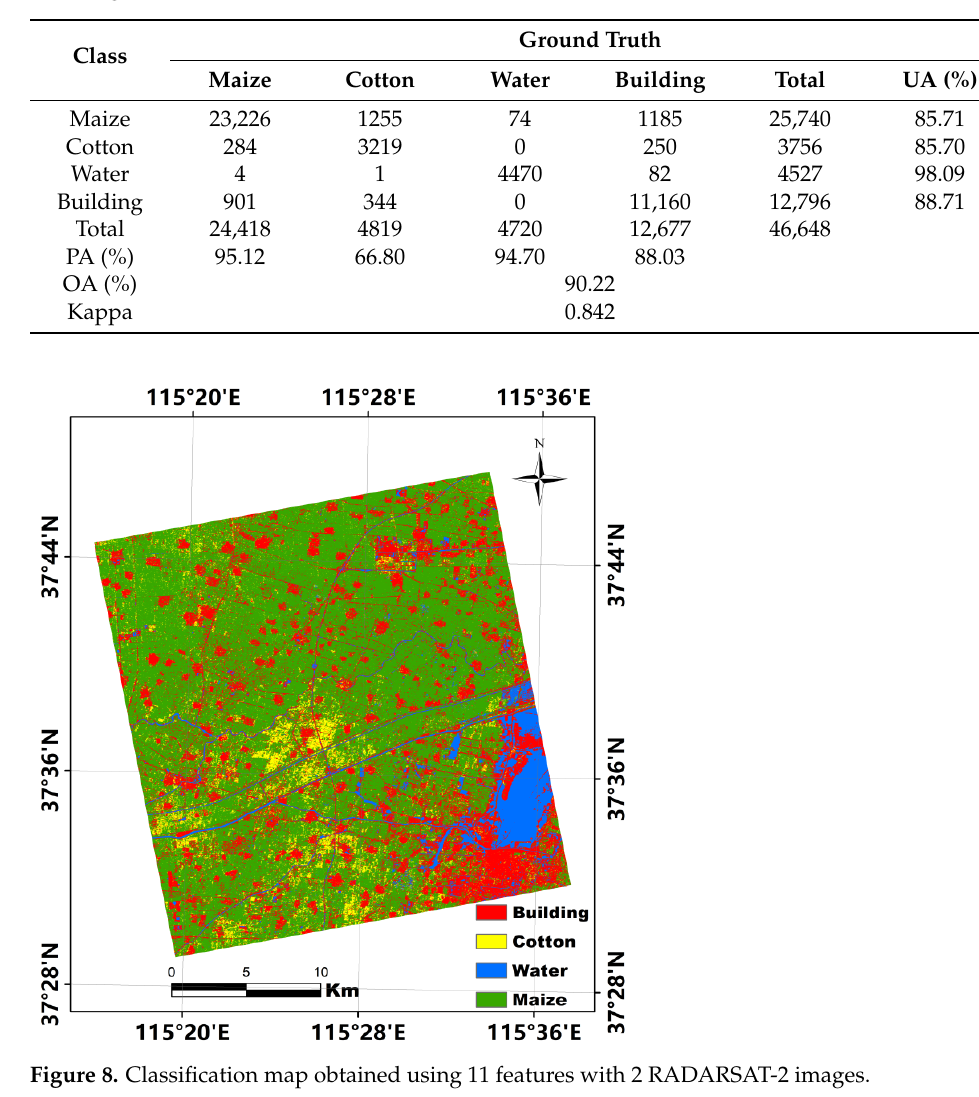
Table 9. Confusion matrix of the 4 land cover types classified using 11 features and the random forest algorithm.